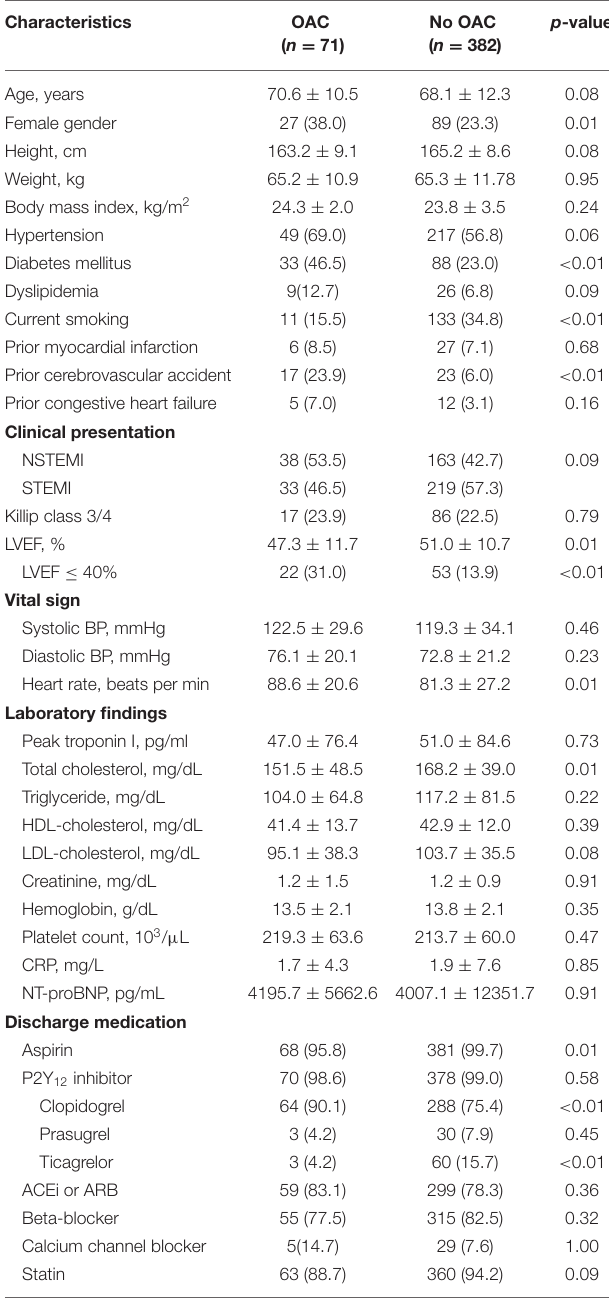
TABLE 1 | Baseline